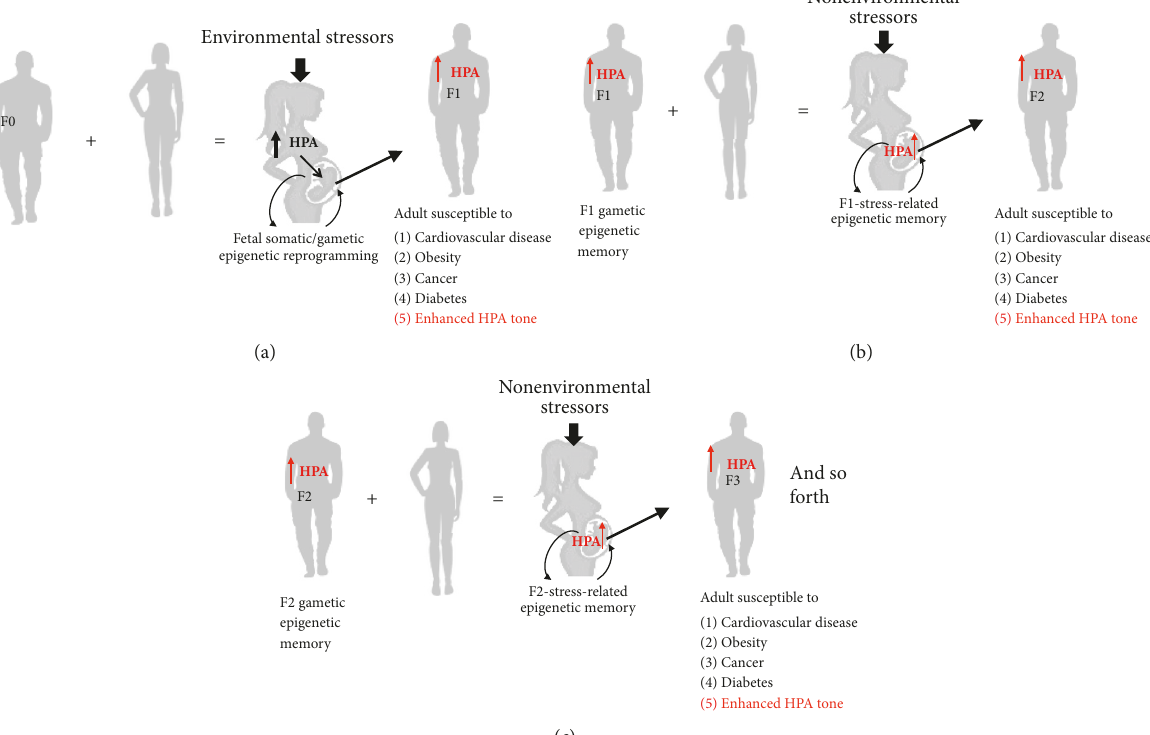
Figure 3: Schemes that illustrate the hypothetical process underlying the transgenerational epigenetic inheritance of stress susceptibility and stress-related diseases via the paternal lineage. (a) When an “unstressed healthy couple” decides to become pregnant, the “biological future” of their child (and indeed of their lineage) might be deeply influenced by the circumstances that surround their pregnancy. In the case where the pregnant mother (F0) experiences stress, the ontogenetic trajectory of the fetus may deviate his/her phenotype to an alternative form that renders the child, and later the adult, susceptible to develop degenerative diseases (see Figure 2) and altered HPA axis physiology (see Figure 1), respectively. The alternative phenotype, however, features increased susceptibility to develop not only stress-related diseases and “stresshypersensitivity”butalsospermatogoniathatkeptarecordoftheprenatalstressepisodeintheirgenomethroughepigeneticmemories. (b) When the spermatozoids derived from the stress-modified precursors of the F1 male fertilize the oocyte of a “na¨ıve” woman, even if the pregnancy proceeds under “no-stress conditions,” the conceived child (F2) inherits the “stressful phenotype” due to the permanence of the F-1 stress-related, gametic epigenetic memory. (c) A similar process takes place in subsequent generations. There is information supporting that this may happens for at least five generations. Epigenetic gametic inheritance can also applied to the maternal lineage, and it is possible that if both members of the couple were exposed to stress during fetal life, their gametes could “double the dosage” of the stress-related epigenetic memories passed on to their descendants making them much more stress prone and stress susceptible throughout their